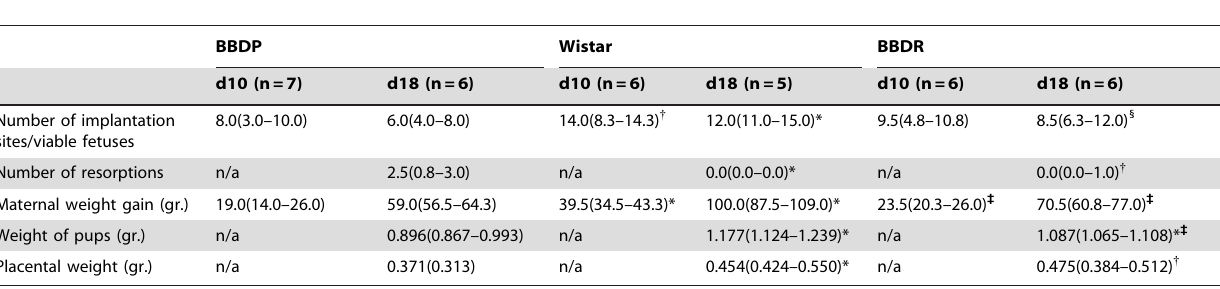
Table 1. Basic characteristics of the different rat